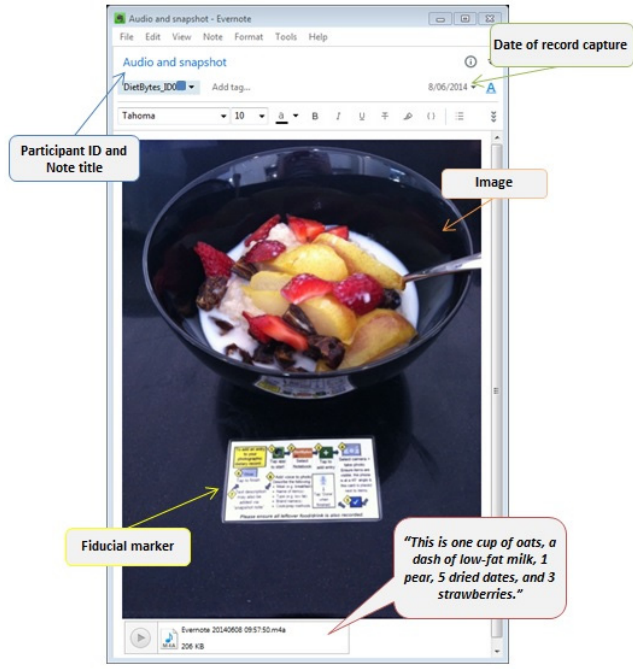
Figure 1. Example of an eating occasion recorded in the image-based dietary records in the Diet Bytes and Baby Bumps study, including supporting voice description, fiducial marker, and date and title of record.